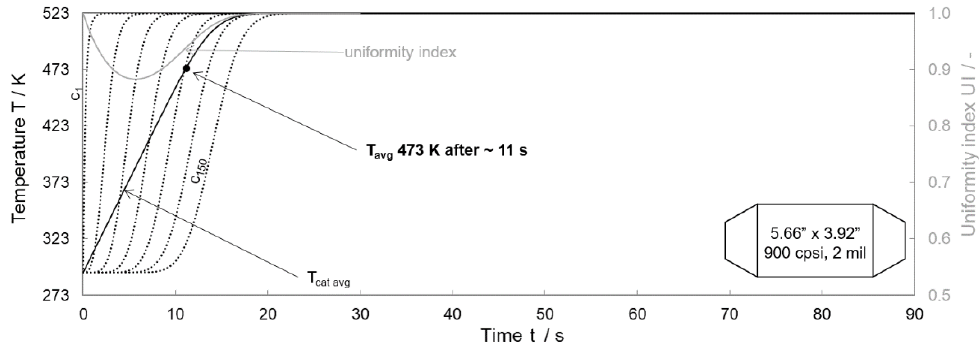
Figure A6. Heat-up of 900 cpsi, 2 mil with reduced length at steady state heat-up.